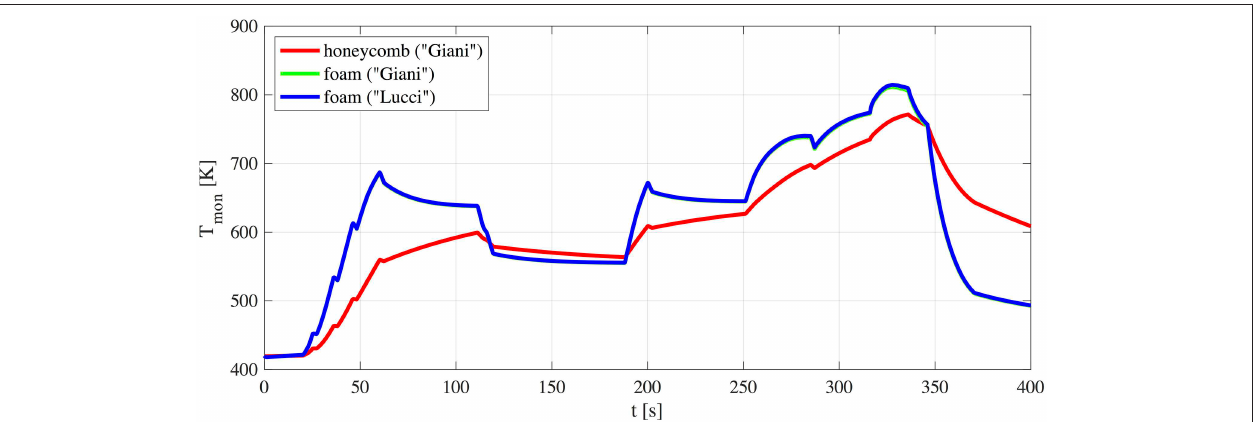
FIGURE 10 | Calculated temperature of the substrates.